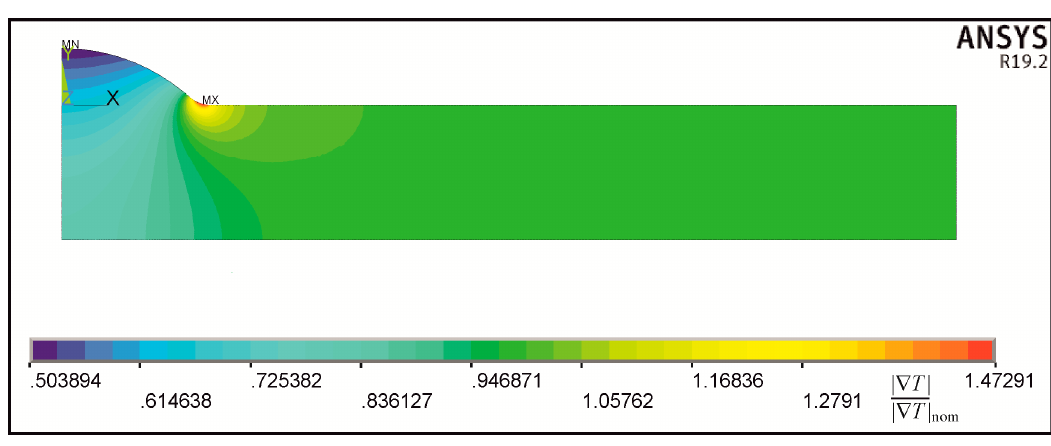
Figure 9. Boundary conditions for a Single–V and Double-V, butt-welded joint subjected to shear. Hence, the two solutions of the SCF values for a Double-V and a Single-V butt-welded joint are identical, regardless of whether both halves of the body are joined together or separated, as shown in Figure 9. The only difference to consider when describing SCF values using approximating formulas, lies in defining the plate thickness t , indicated here as t sym and t asym . By considering t sym = 2 t asym and taking into account Equation (2), the relationship between Y sym and Y asym is 2 asym sym